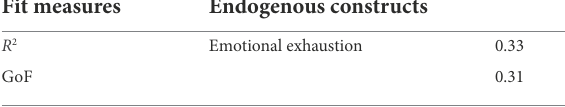
TABLE 3 Structural